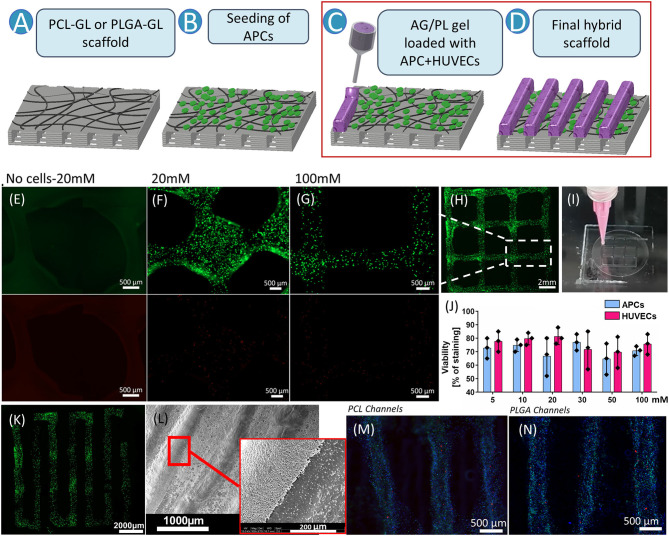
Effect of cross-linking on structure fidelity and cell viability. (A–D) Schematic representation of the final hybrid scaffold preparation following the specific steps (A,B were already described in Figure 3); (C) incorporation of APCs-HUVECs coculture in sodium alginate/Pluronic F127 gel (AG/PL); (D) hydrogel patterning on the seeded scaffold for the final assembling of the Hybrid scaffold. (E,G) show highly magnified fields of control (no cells) (E) 20 mM (F) and 100 mM (G) crosslinked gel; (E) shows the absence of unspecific stain in the gel without cells; (F,G) show the living cells stained with calcein (Green) while dead cells are stained with EthD-III (red); (H) Fluorescent microscopy image of the structure of the bioprinted structure in the shape of a 10 × 10 mm grid; Dotted square shows the magnified filed for (G); (I) Picture of the 10 × 10 mm bioprinted grid; (J) Bar graph of cell viability of APCs and HUVECs loaded into the AG/PL gel and assessed after the exposure to different concentration of CaCl2. (K) Fluorescence image of the bioprinted structure of the final pattern for the hybrid Scaffold composition; (L) SEM picture of AG/PL gel printed onto the scaffold; (M,N) Representative images of the maintained pattern of the co-culture in the AG/PL gel extruded onto scaffold, after 5 days of incubation. APCs stained with Dil (red), HUVECs with DiO (green) and nuclei of both cell type with DAPI (blue). (M) poly(ε-caprolactone) with gelatin nanofibers coated with bioprinted sodium alginate/Pluronic F127 gel (PCL-GL + AG/PL) loaded with HUVECs + APCs; (N) polylactic-co-glycolic acid with gelatin nanofibers coated with bioprinted sodium alginate/Pluronic F127 gel (PLGA-GL + AG/PL) loaded with HUVECs + APCs.